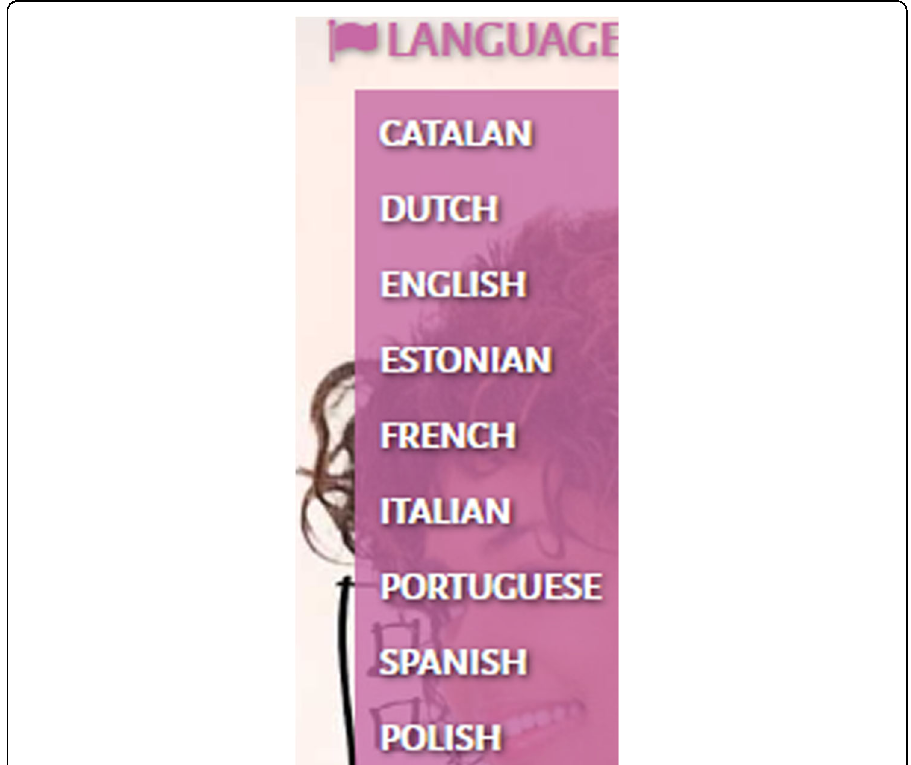
Fig. 12 Drop-down menu for the selection of